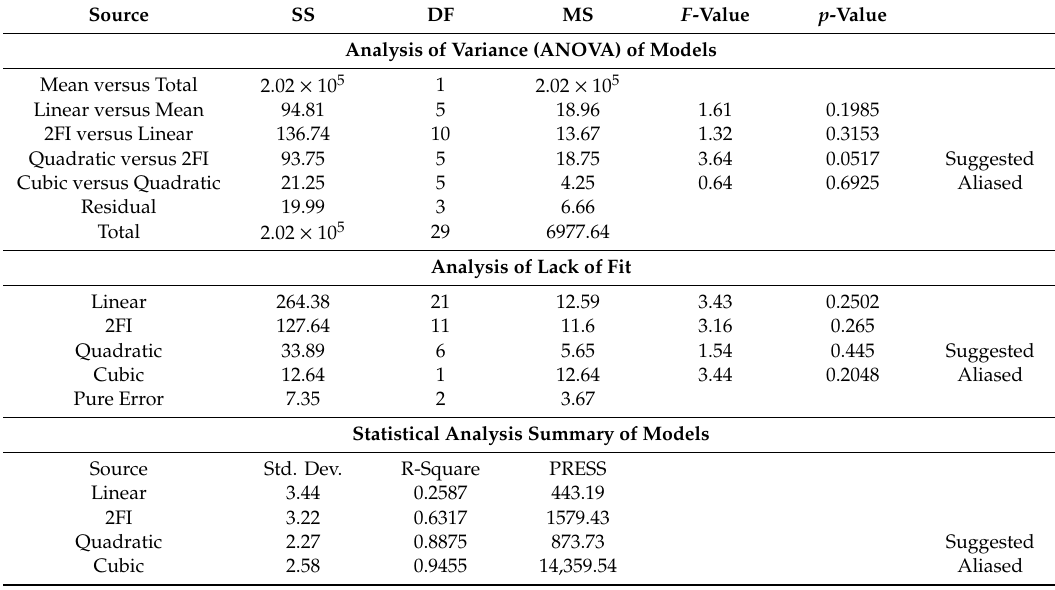
Table 6. Statistical analysis of models for modeling rougher flotation of